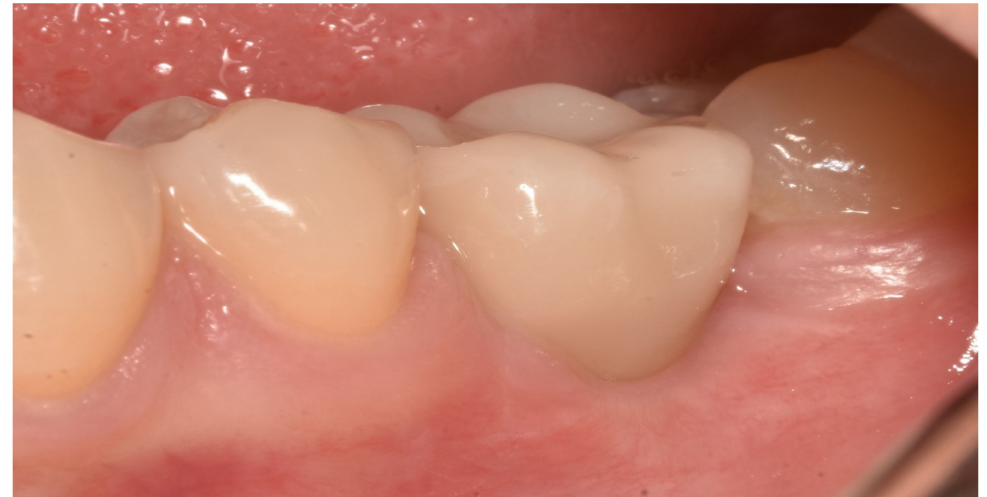
Figure 4. Prosthetic placement of the